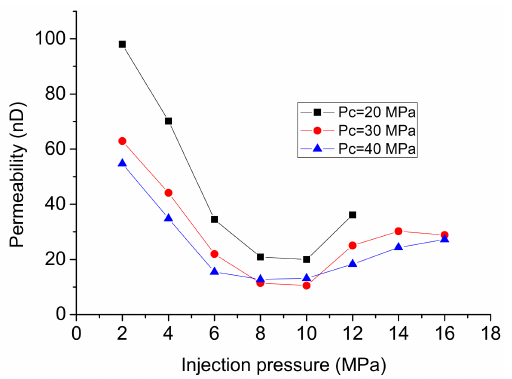
Figure 7. Relationship between the calculated permeability to CO 2 and injection pressures under transient